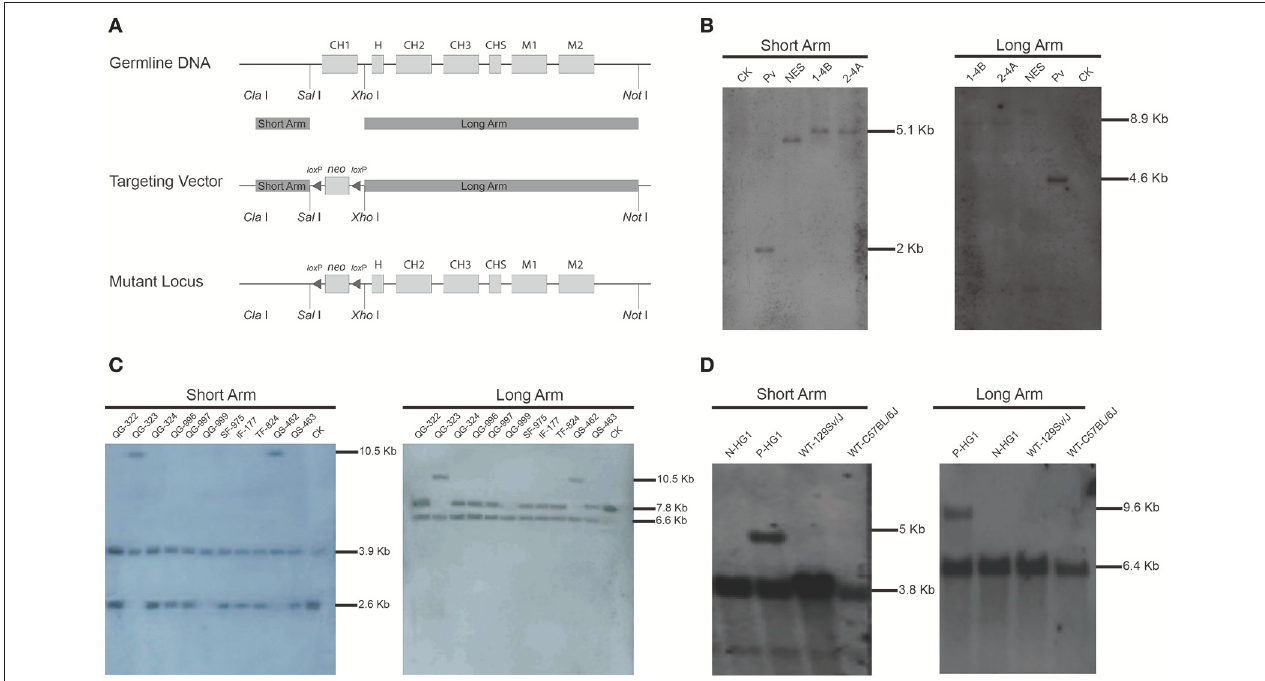
FIGURE 1 | Construction of the targeting vector and generation of the γ 1-CH1 deleted mice. (A) Targeting strategy for the genetic modification designed to delete the γ 1 CH1 exon. (B) Identification of correctly targeted ES cell clones by Southern blotting. Southern blotting was performed using the DIG-labeled probe for the neo gene. Genomic DNA was digested with Xho I + Eco R I and Sal I + Hin d III to detect the short (5.05kb) and long (8.94kb) homologous arms, respectively. CK: 129/SvJ wild type mice; Pv: pPNIII vector digested with Eco R I; NES: negative ES cell clone 1–2A. (C) Identification of homozygous knockout mice by Southern blotting. Genomic DNA was digested with Sph I + Dra I to detect the homologous arms. The positive mice, QG-999, exhibited a 6.63kb band for the long homologous arm and a 3.91kb band for the short homologous arm. (D) Identification of HG1 mice with the neo gene deleted by Southern blotting. Genomic DNA was digested with Sph I + Nco I and Sph I + Eco N I to detect the short and long homologous arms, respectively. Positive mice exhibited a 5.06kb band for the short homologous arm and a 9.44kb band for the long homologous arm. P-mouse, positive mouse; N-mouse, negative mouse.